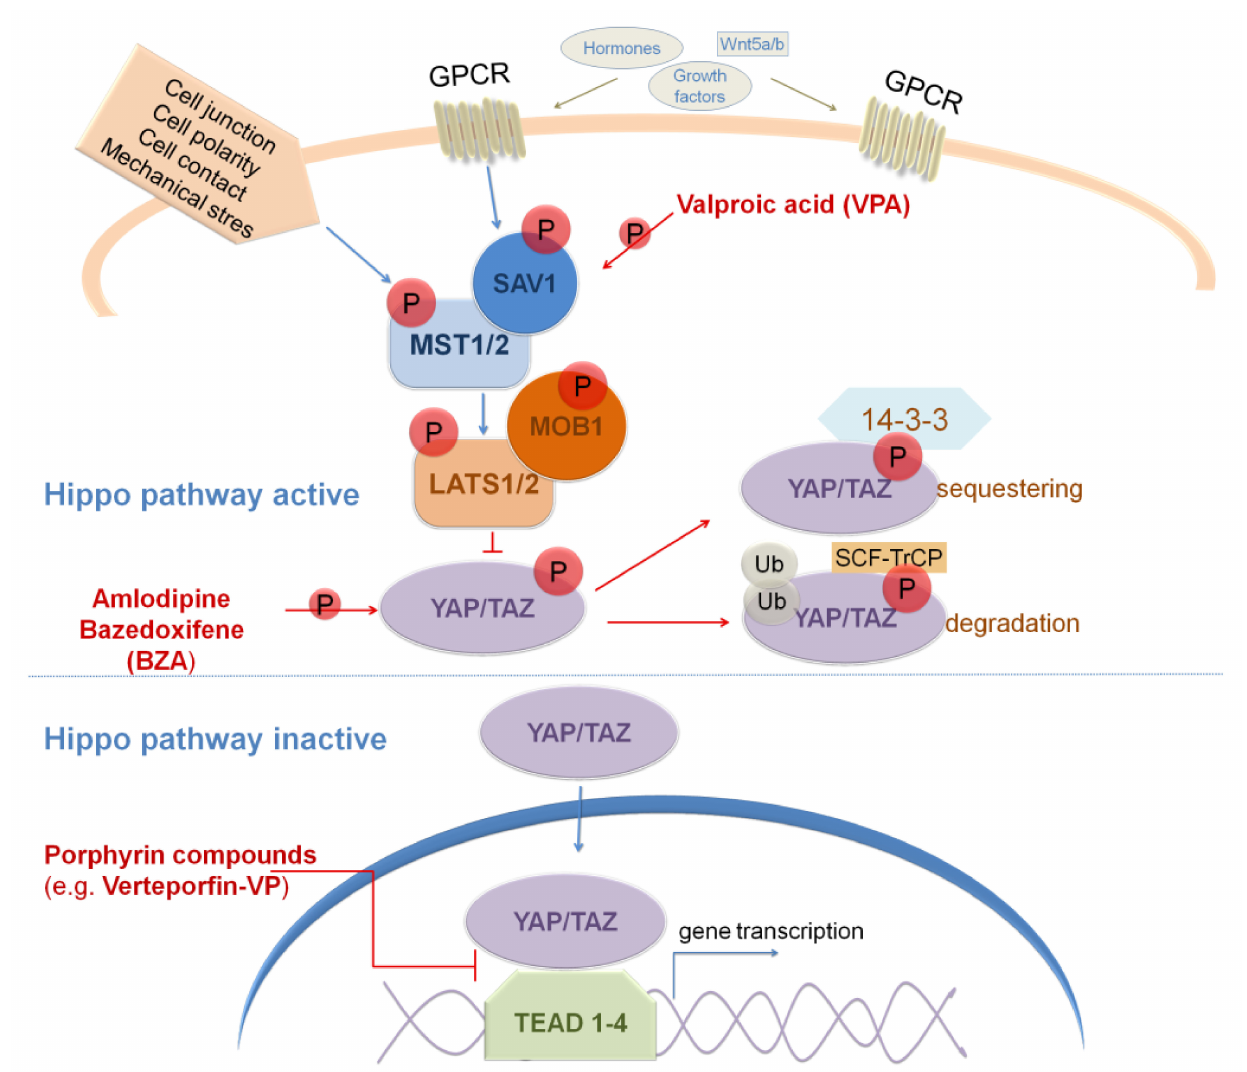
Figure 7. The canonical Hippo pathway and its pharmaceutical inhibitors. Various extracellular signals including mechanical stress, cellular contact, hormones and growth factors activates Hippo signaling cascades that through serial phosphorylations involving block of kinases inhibits nuclear translocation of transcriptional co-activator YAP/TAZ and consequently their involvement in the regulation of gene transcription. When Hippo pathway is inactive, YAP/TAZ translocates to the nucleus, associates with TEAD family of transcription factors and participates in the regulation of target genes expression. Inhibitors that target important pathway components are indicated in